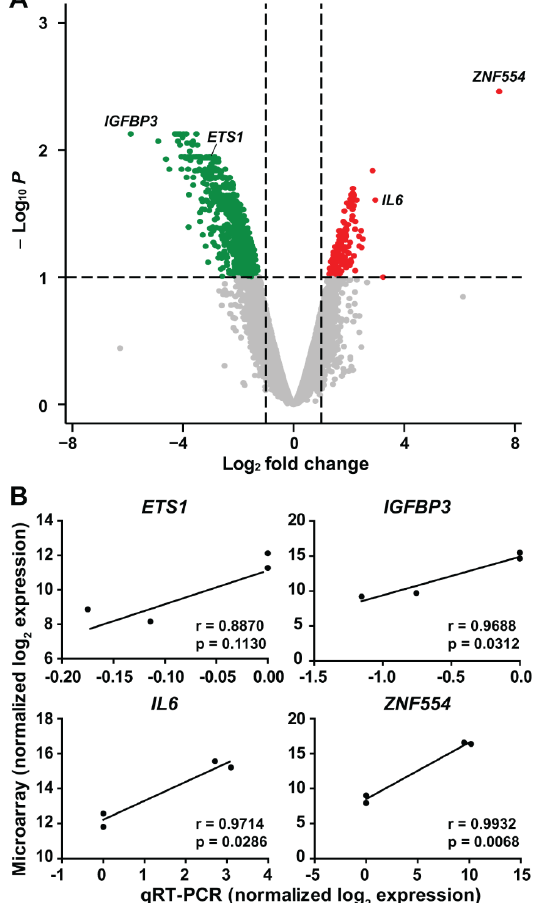
Figure 4. Genome-wide expression changes in U87 glioblastoma cells overexpressing ZNF554 . ( A ) All 18,834 genes are represented in terms of their measured di ff erences in abundance ( x -axis) and the significance of the di ff erence ( y -axis) on a volcano plot. The significance is represented as a negative log (base 10) of the adjusted p -value so that more significant di ff erences in expression are plotted higher on the y -axis. Dotted lines represent the thresholds used to select the probes for di ff erentially expressed (DE) genes: < − 1 and > 1 for the magnitude of di ff erential expression and pFDR of < 0.1 for statistical significance. According to these criteria, of the 899 DE genes, 145 were up-regulated (depicted with red), while 754 were down-regulated (depicted with dark green) in U87 cells transfected with ZNF554 . ( B ) Correlation of microarray and qRT-PCR results for the selected genes ( ETS1 , IGFBP3 , IL6 , and ZNF554 ). The di ff erences in the transcription of genes were log 2 -transformed and plotted against each other. Statistical results of Pearson’s correlation are indicated ( p < 0.05 was considered significant). Two independent experiments in duplicates were performed. ETS proto-oncogene 1, ETS1; insulin-like growth factor binding protein 3, IGFBP3; interleukin 6, IL6; positive false-discovery rate, pFDR; zinc finger protein 554,